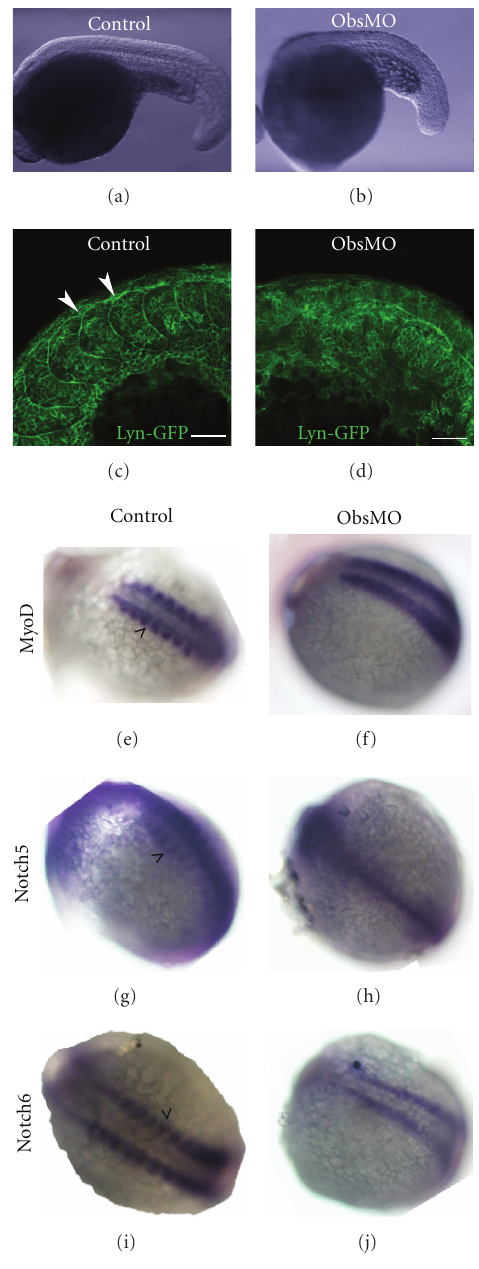
Figure 1: Obscurin A depletion results in abnormalities of myotome development. (a, b) Compared to control embryos at 20hpf, an obscurin-A-depleted embryo (ObsMO) demonstrates shortening of the tail and indistinct somite boundaries. The skeletal muscle abnormalities are associated with irregularities of cell morphology as noted by cell membrane localization of lyn-GFP (c, d). Note that in control embryos, (c) lyn-GFP accumulates at the somite boundary (arrowheads). In morphant embryos (d), distinct somite boundaries are di ffi cult to identify. (e–j) RNA in situ hybridization using riboprobes for MyoD , Notch5 , and Notch6 in control (e)–(i) and obscurin A (f), (h), (j) morphant embryos demonstrate maintained expression but diminished periodicity of these somite markers suggesting preserved myocyte commitment but impaired somite organization in the setting of obscurin depletion. Scale bars are 50 μ m (a)–(d) and 500 μ m